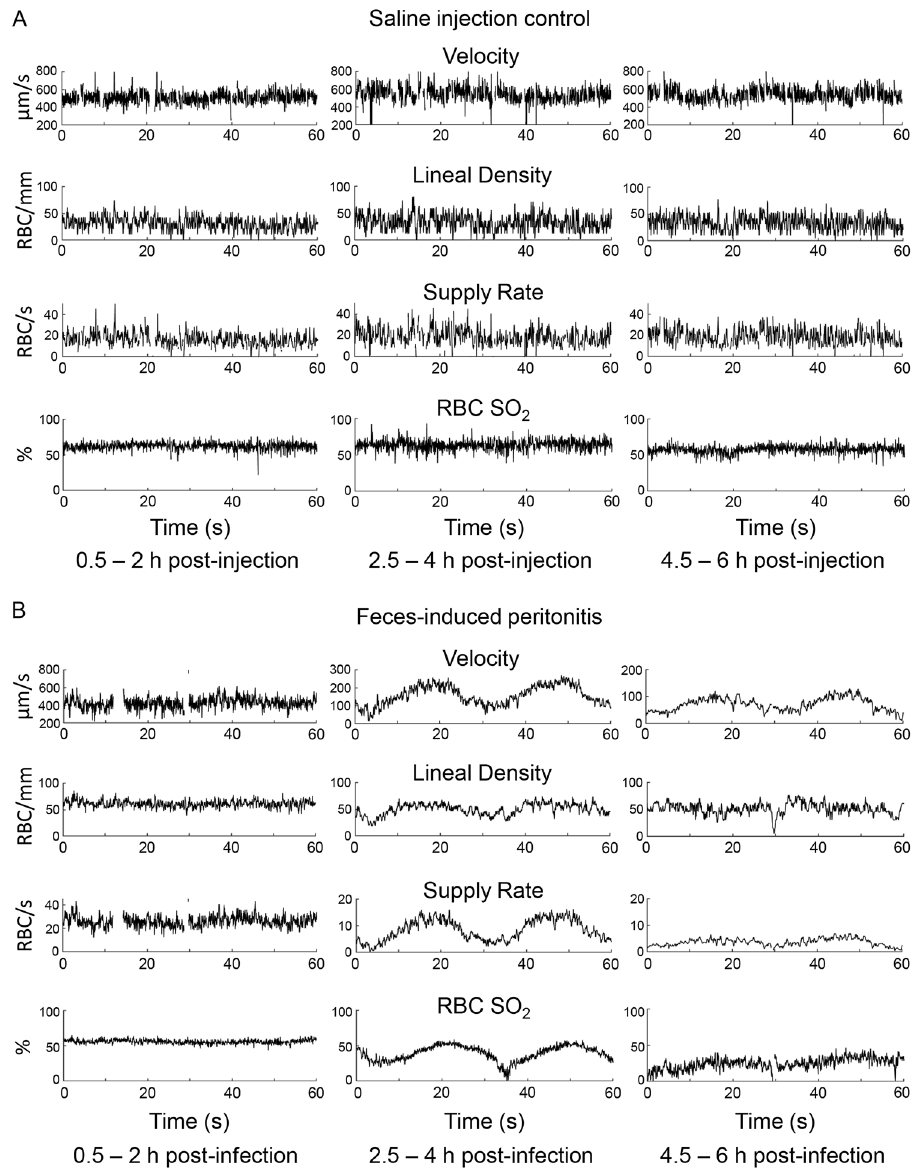
Figure 5. Low-frequency oscillations in capillary red blood cell (RBC) flow dynamics and O 2 saturation emerge in rat skeletal muscle after induction of fecal peritonitis. Microhemodynamic (RBC velocity, lineal density (reflective of hematocrit) and supply rate) and RBC O 2 saturation (SO 2 ) measurements from intravital video microscopy recordings are shown for a capillary from a control rat ( A ) and a feces-injected rat ( B ). The imaging was performed for 6 h after intraperitoneal injection of normal saline (control) or fecal slurry (feces- induced peritonitis). RBC SO 2 measurements are based on the optical density ratio of the O 2 -dependent to O 2 -independent λ